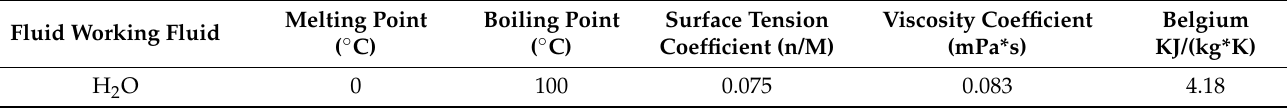
Table 2. Parameters of each liquid working fluid at standard atmospheric pressure and room